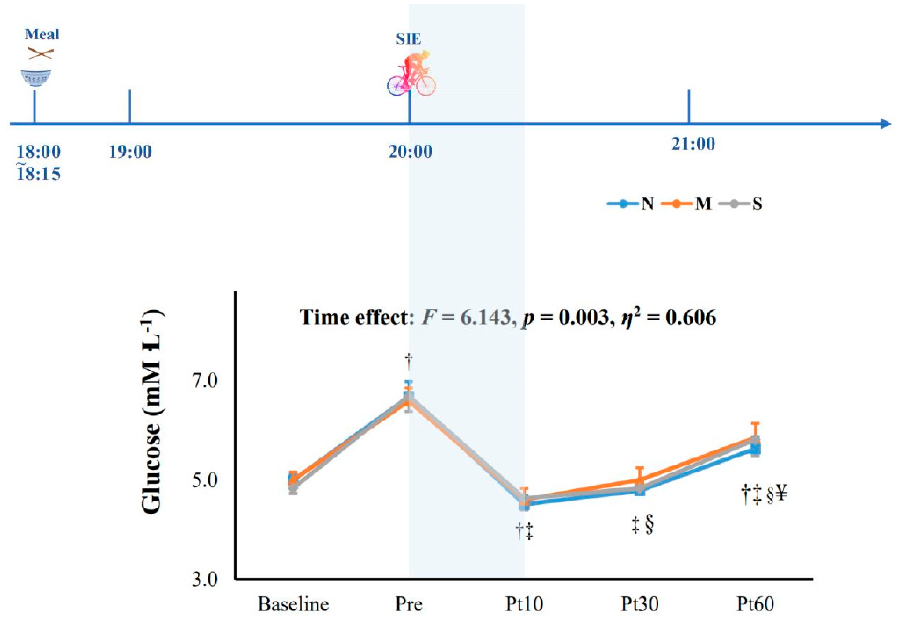
Figure 5. Glucose responses to sprint interval exercise (SIE) under normoxia (20.9% O 2 ) and hypoxia (15.4%O 2, and 11.2%). The shaded part indicates oxygen condition. N: SIE in normoxia; M: SIE in moderate hypoxia; S: SIE in severe hypoxia; Pre: pre-exercise; Post 10: 10 min after exercise; Post 30: 30 min after exercise; Post 60: 60 min after exercise. † p < 0.05 vs. baseline; ‡ p < 0.05 vs. Pre; § p < 0.05 vs. Post 10; ¥ p < 0.05 vs. Post 30.